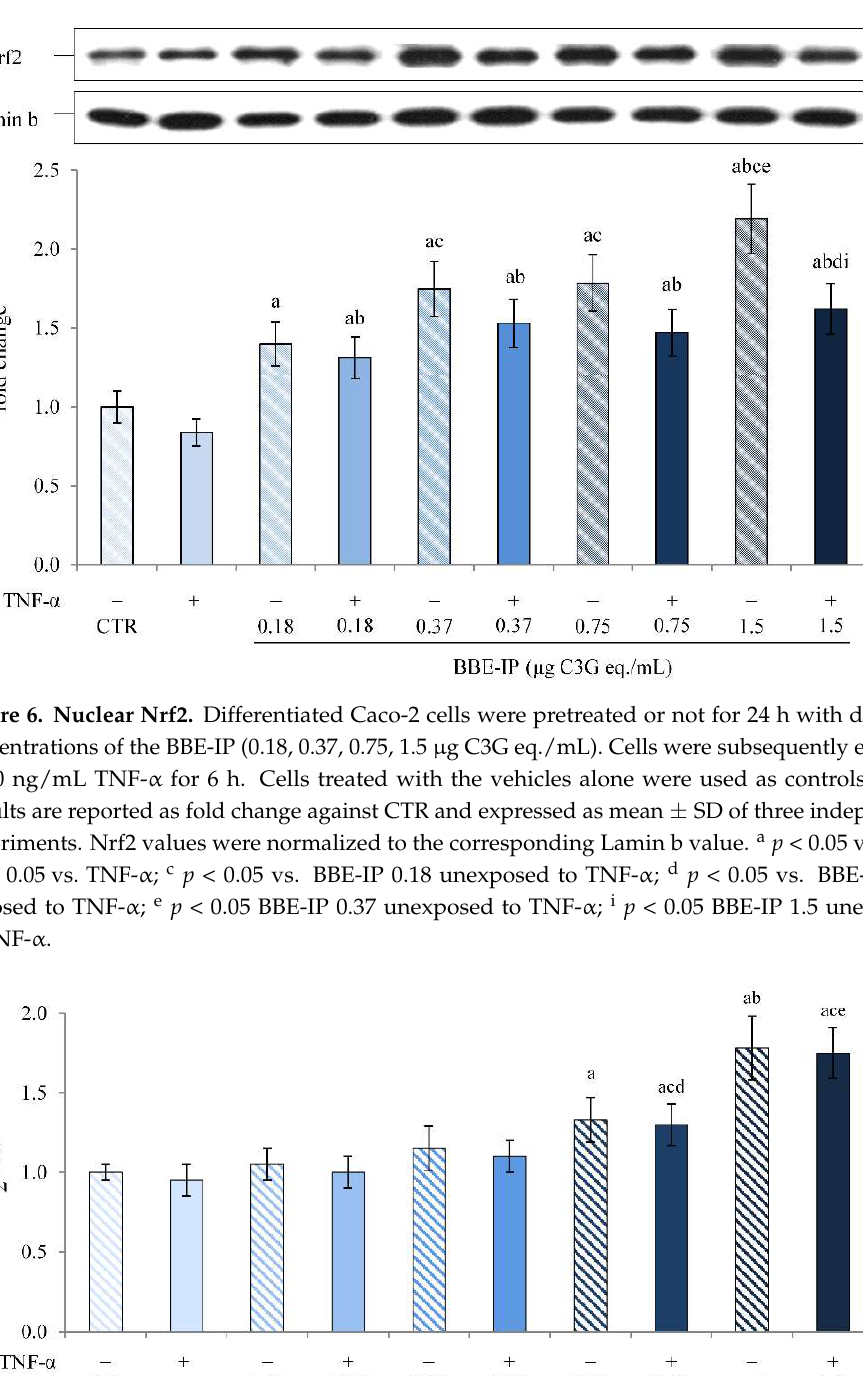
Figure 7. NQO1 mRNA expression. Differentiated Caco-2 cells were pretreated or not for 24 h with different concentrations of the BBE-IP (0.18, 0.37, 0.75, 1.5 µ g C3G eq./mL). Cells were subsequently exposed to 50 ng/mL TNF- α for 6 h. Cells treated with the vehicles alone were used as controls (CTR). NQO-1 mRNA expression was analyzed by real time PCR and data are expressed as 2 − ∆∆ Ct and normalized to CTR. 18S rRNA was used as housekeeping gene. a p < 0.05 vs. CTR; b p < 0.05 vs. all BBE-IP concentrations not exposed to TNF- α ; c p < 0.05 vs. TNF- α ; d p < 0.05 vs. BBE-IP 0.18 µ g C3G eq./mL; e p < 0.05 vs. all BBE-IP concentrations exposed to TNF- α